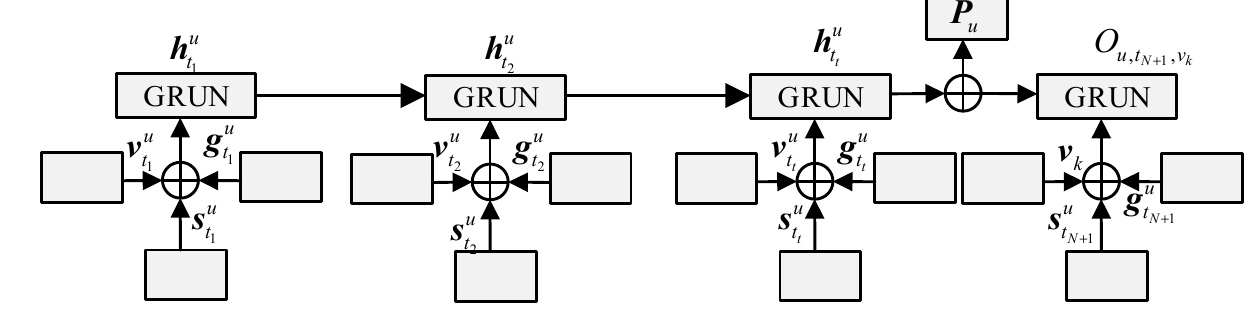
Figure 2. GS-GRUN model structure.